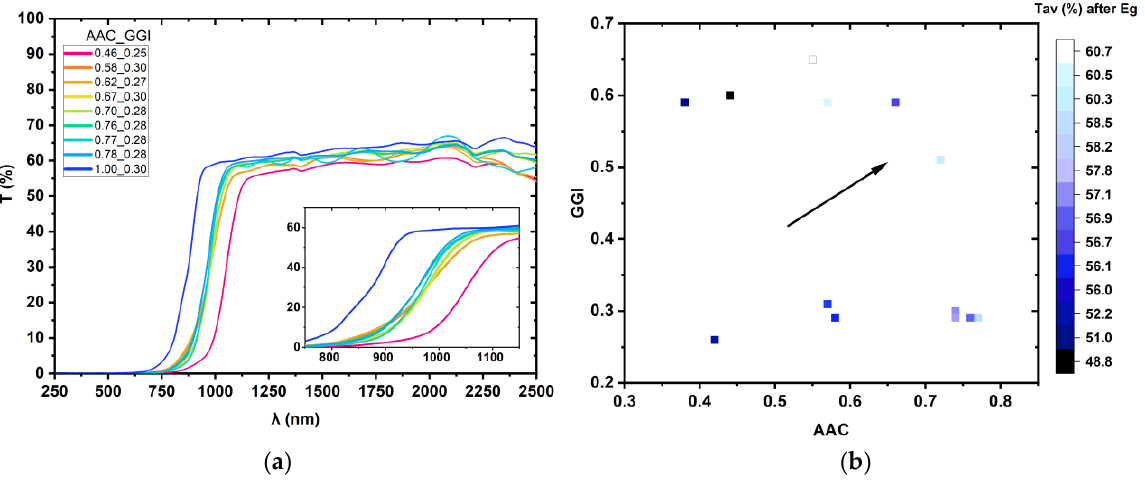
Figure 1. ( a ) Transmission curves of ACIGSe with low GGI (approx. 0.3) and varying AAC ratio; ( b ) Average sub-gap transmission values as a function of GGI and AAC (arrow indicating increasing trend).